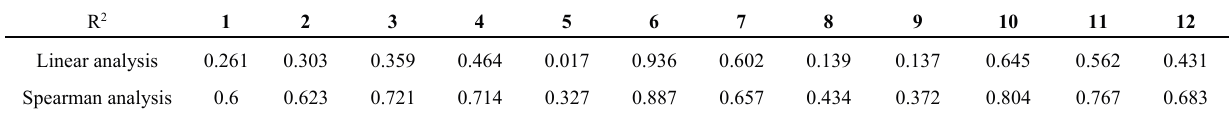
Table 1. Correlation between PM 2.5 and temperature in a